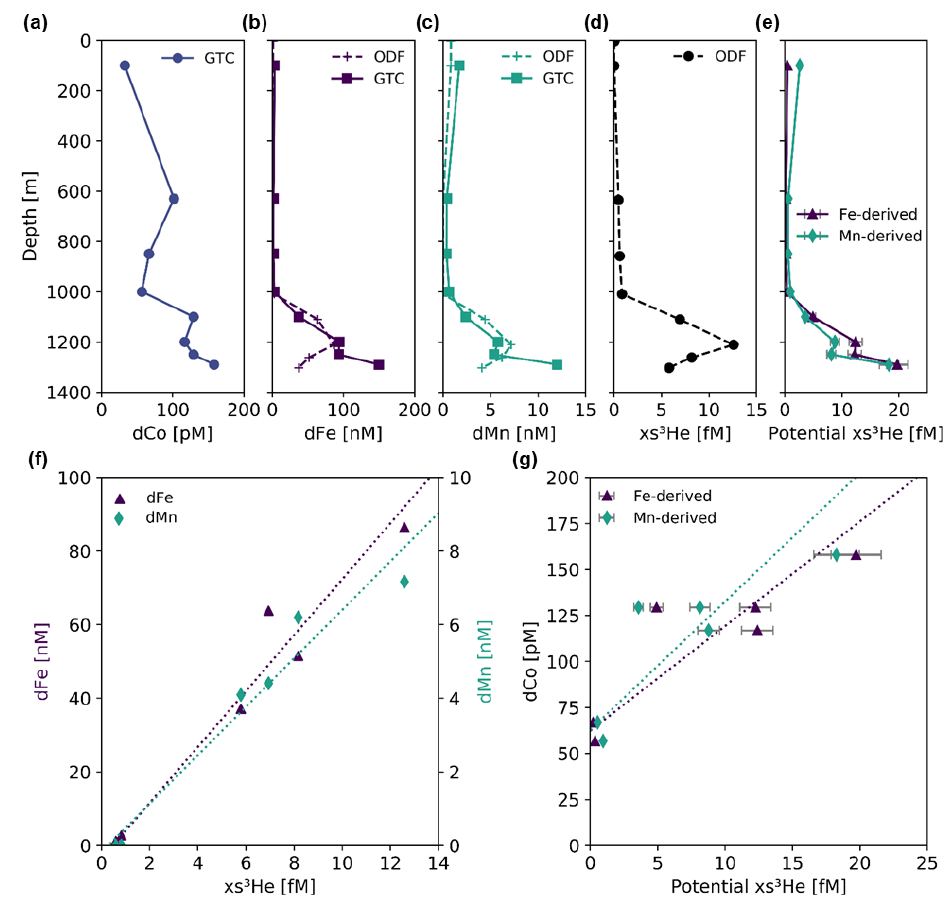
Figure 11. Profiles of (a) dCo, (b) dFe, (c) dMn and (d) excess 3 He ( xs 3 He) from the Loihi Seamount station (Station 18.6) from both the trace-metal-clean GEOTRACES CTD carousel (GTC; solid lines) and the general CTD from the Ocean Data Facility (ODF; dashed lines). To estimate xs 3 He values for the GTC cast, (f) the ODF cast’s dFe: xs 3 He and dMn: xs 3 He ratios (7.6 ± 0.7mol:µmol, R 2 = 0.95 and 0.66 ± 0.06mol:µmol, R 2 = 0.95, respectively) were used to predict (e) potential xs 3 He values with respect to the GTC dFe and dMn values. (g) The GTC dCo:potential xs 3 He ratios were 6 ± 1mol:mmol (Fe-derived, R 2 = 0.78) and 7 ± 2mol:mmol (Mn-derived, R 2 = 0.71). For the trace metal: xs 3 He regressions, only samples below 750m were used to isolate the hydrothermal signal from surface processes. Error bars for potential xs 3 He (e, g) indicate the propagation of error from the regression slope in panel (f)